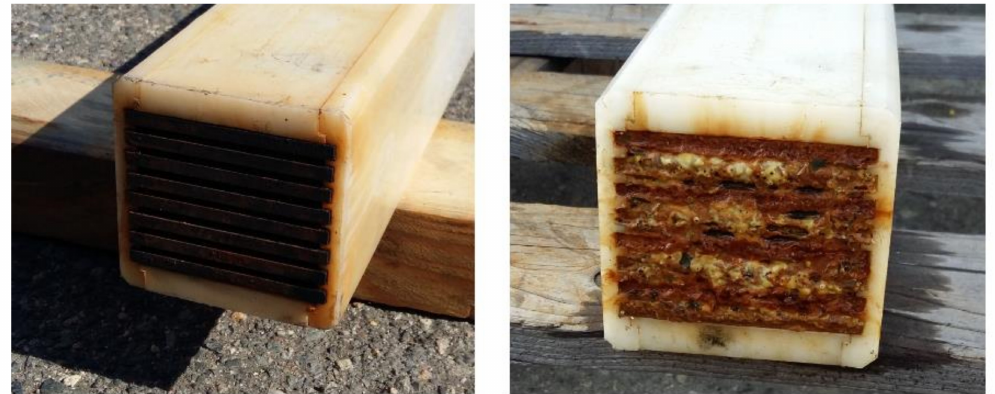
Figure 2. Fresh and passivated electrode pack.